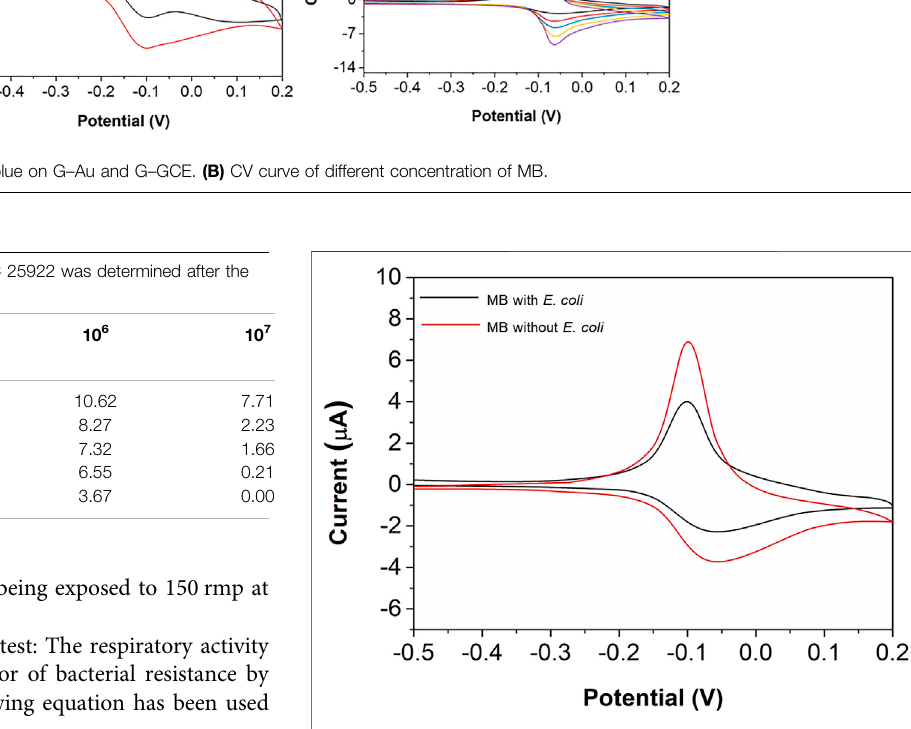
FIGURE 2 | CV curve of MB in the presence and absence of b